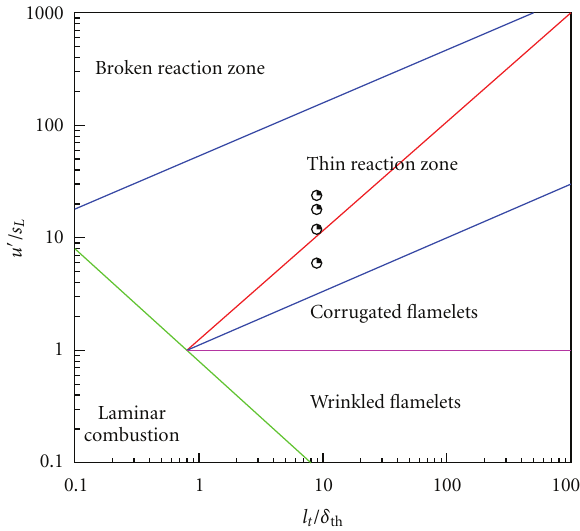
Figure 1: Modified combustion diagram of Peters [18, 19] with positions of current